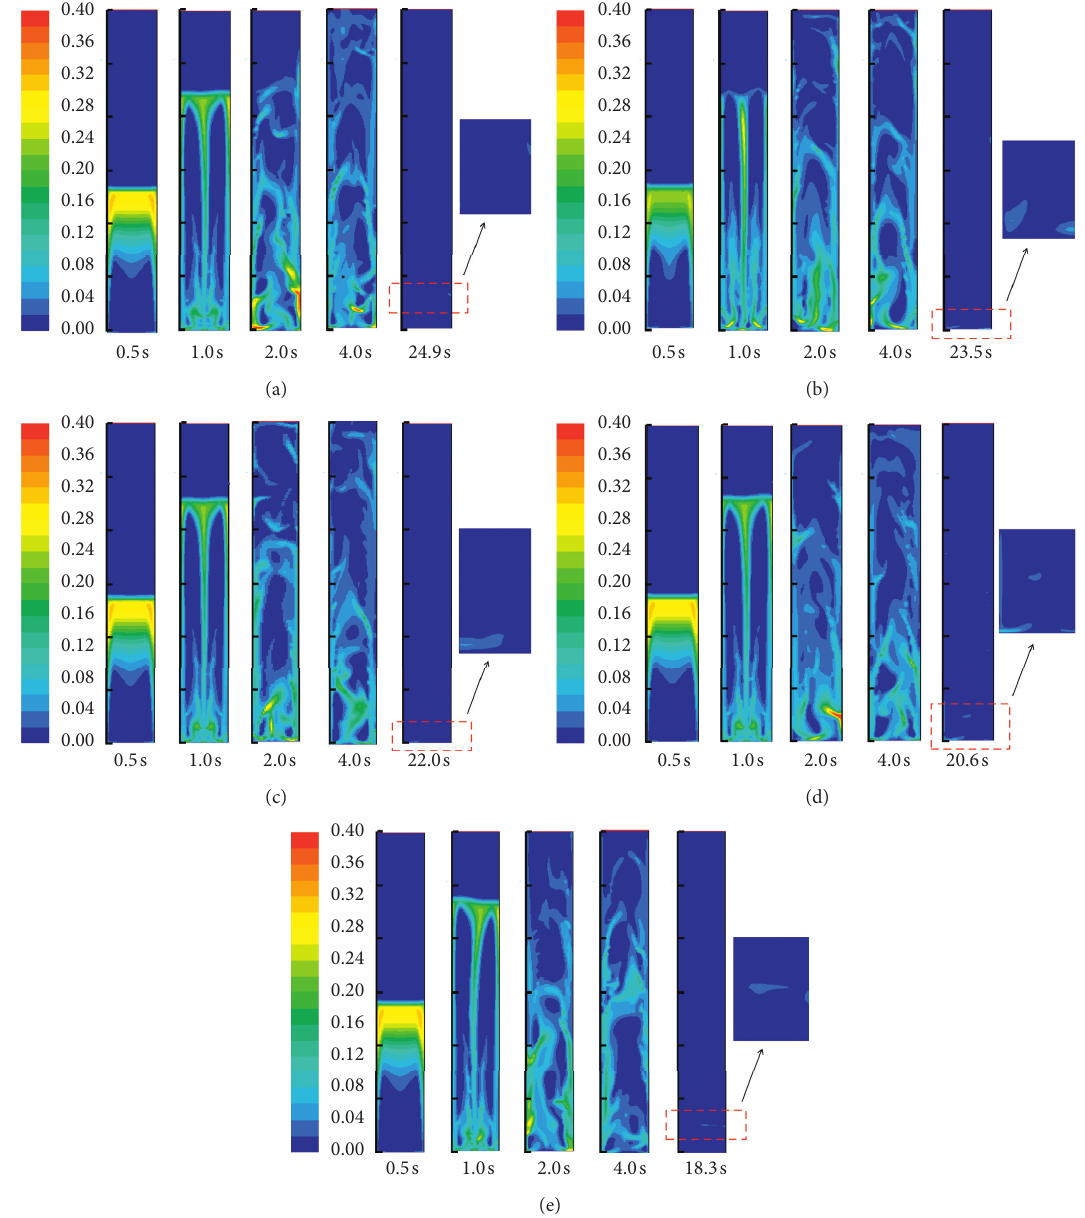
Figure 8: Volume fraction of tar mist: d � 0.20 mm and ρ � 900kg/m 3 . (a) u � 0.68m/s. (b) u � 0.69m/s. (c) u � 0.70m/s. (d) u � 0.71m/s. (e) u � 0.72